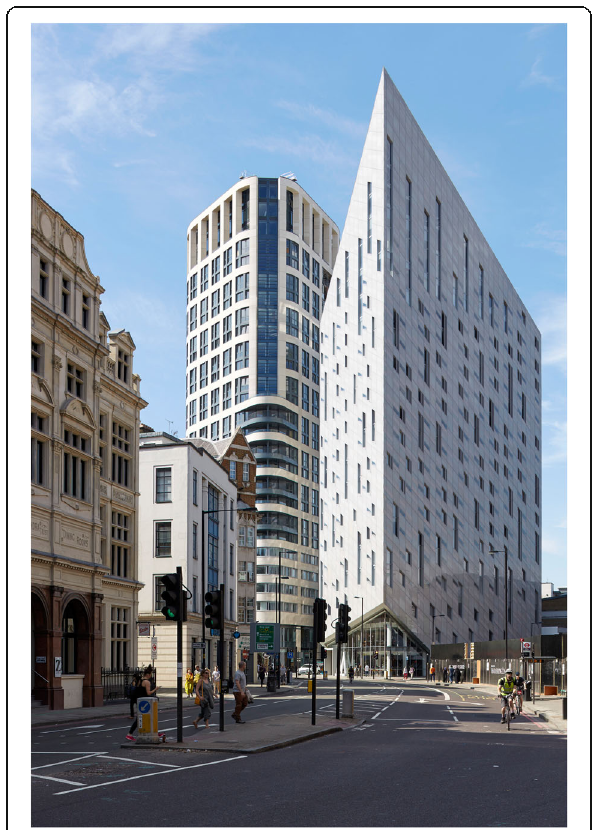
Fig. 4 Montcalm Shoreditch Signature Tower Hotel, 151 – 157 City Road, London, completed 2015 by SMC Alsop Architects. What is lost when architectural design focuses on eye appeal? [Figure copyright Ian Ritchie,